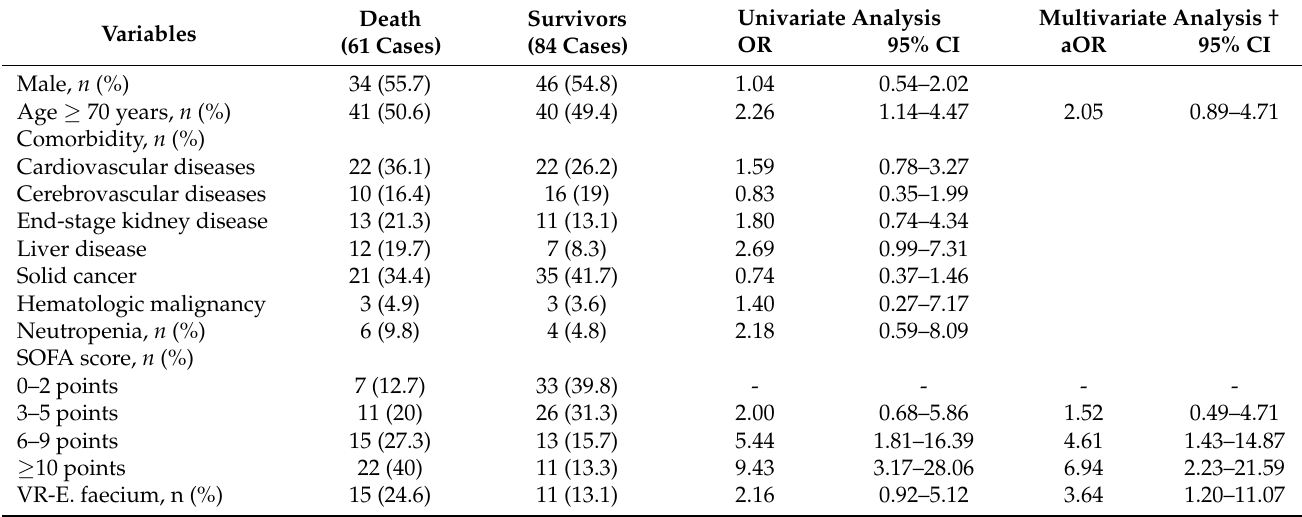
Table 2. Factors predicting 30–day mortality among patients with Enterococcus faecium infections by univariate and multivariate